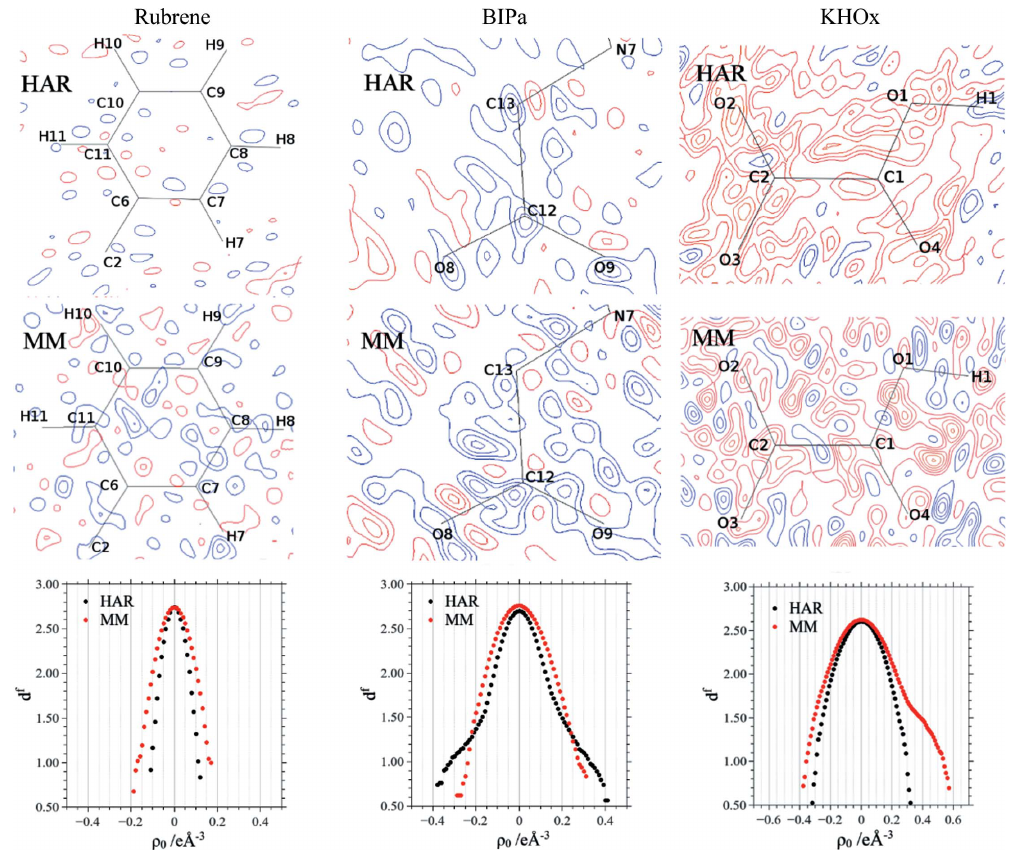
Figure 3 Residual density plots for rubrene, BIPa and KHOx of the HARs (top row) and the MMs (middle row) calculated with the full resolution and the observed reflections as given in Table 2. Blue denotes positive and red negative, and the contour interval is 0.05 e A˚ (cid:6) 3 . The bottom row shows Henn– Meindl fractal dimension plots based on the complete unit-cell electron density. Additional cut planes through other ions of BIPa are given in the supporting information. They show the same